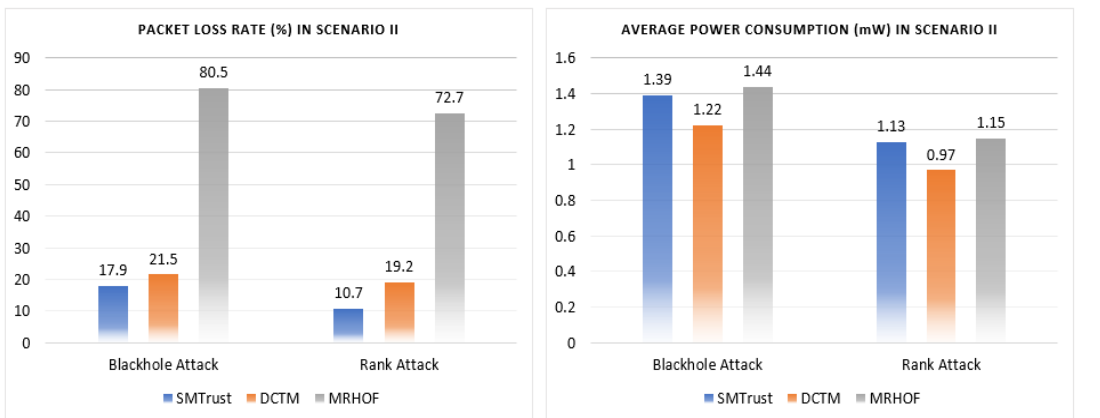
Figure 6. Results comparison of network performance under Blackhole and Rank attack in Scenario I.